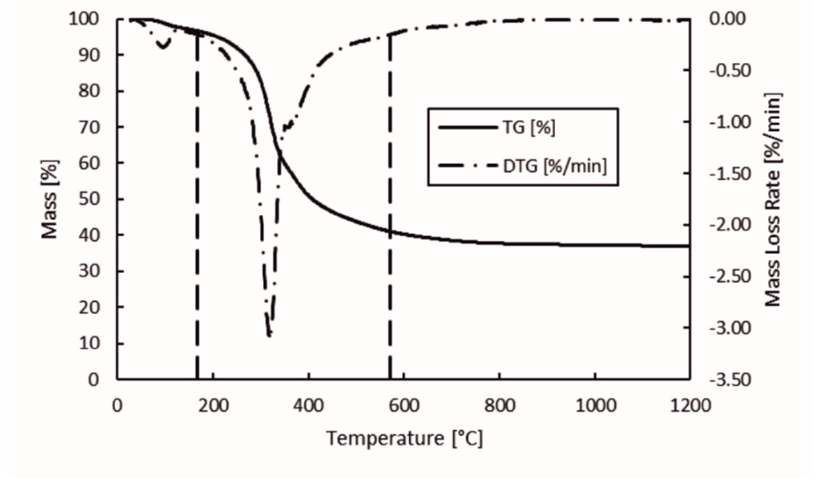
Figure 4. Mass loss and mass loss rate of hydrolysis lignin in pyrolysis. The gas components of the hydrolysis lignin pyrolysis product gas were analyzed with MS connected to TGA. The mass spectra is presented in 3D in Figures 5 and 6. Even though the scan width ranged from m / z values of 0 to 100 (Figure 5), the species in pyrolysis gas were identified between the m / z values of 0 and 45 (Figure 6). This was done for two reasons: the signal intensities were highest in this range and there was less